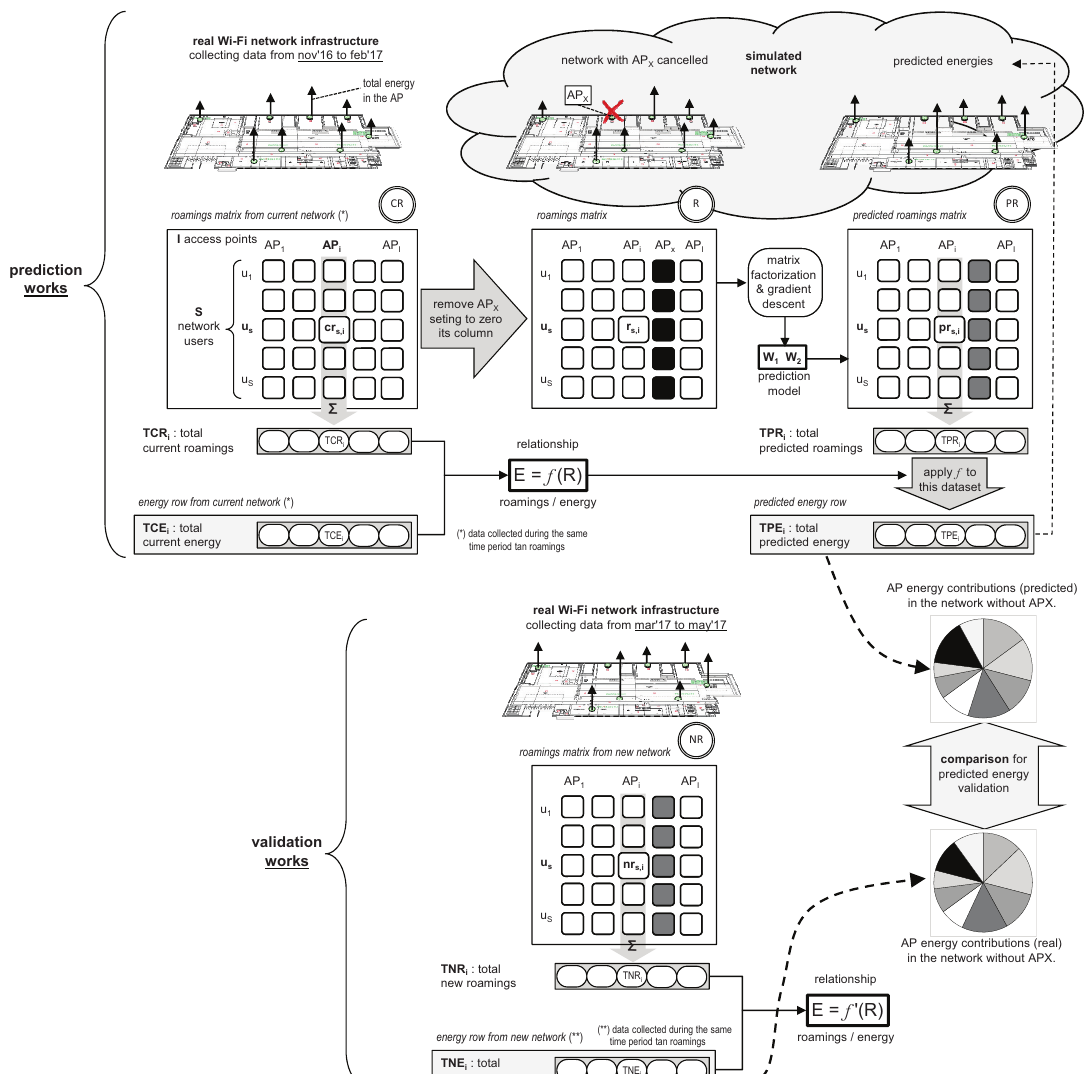
Figure 1. Methodology for predicting the energy in the access points after removing one of